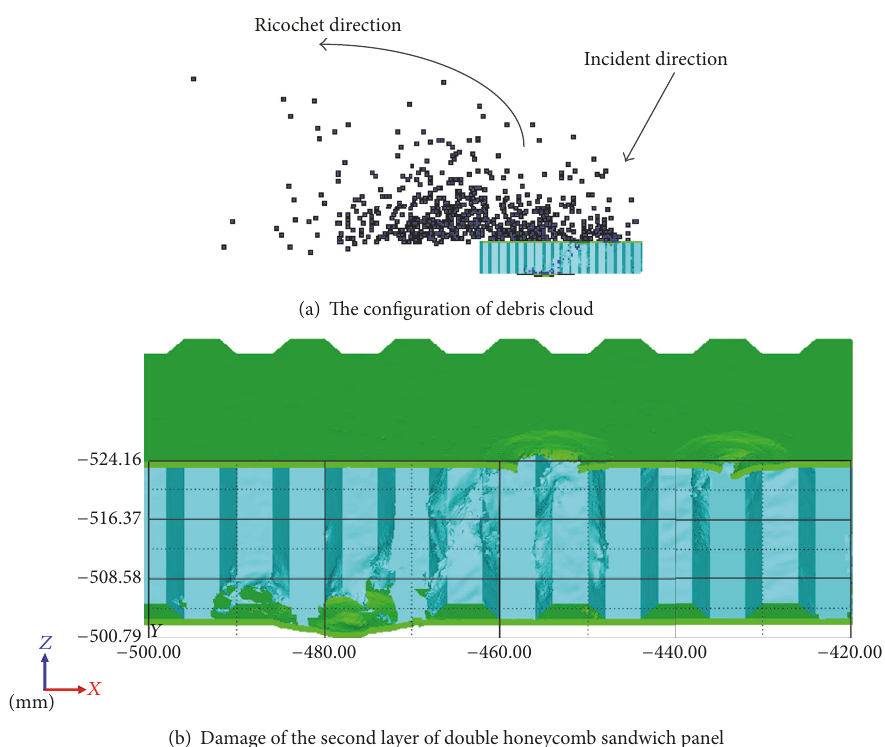
Figure 6: Second layer of double honeycomb sandwich panels (incidence angle is 45 ∘